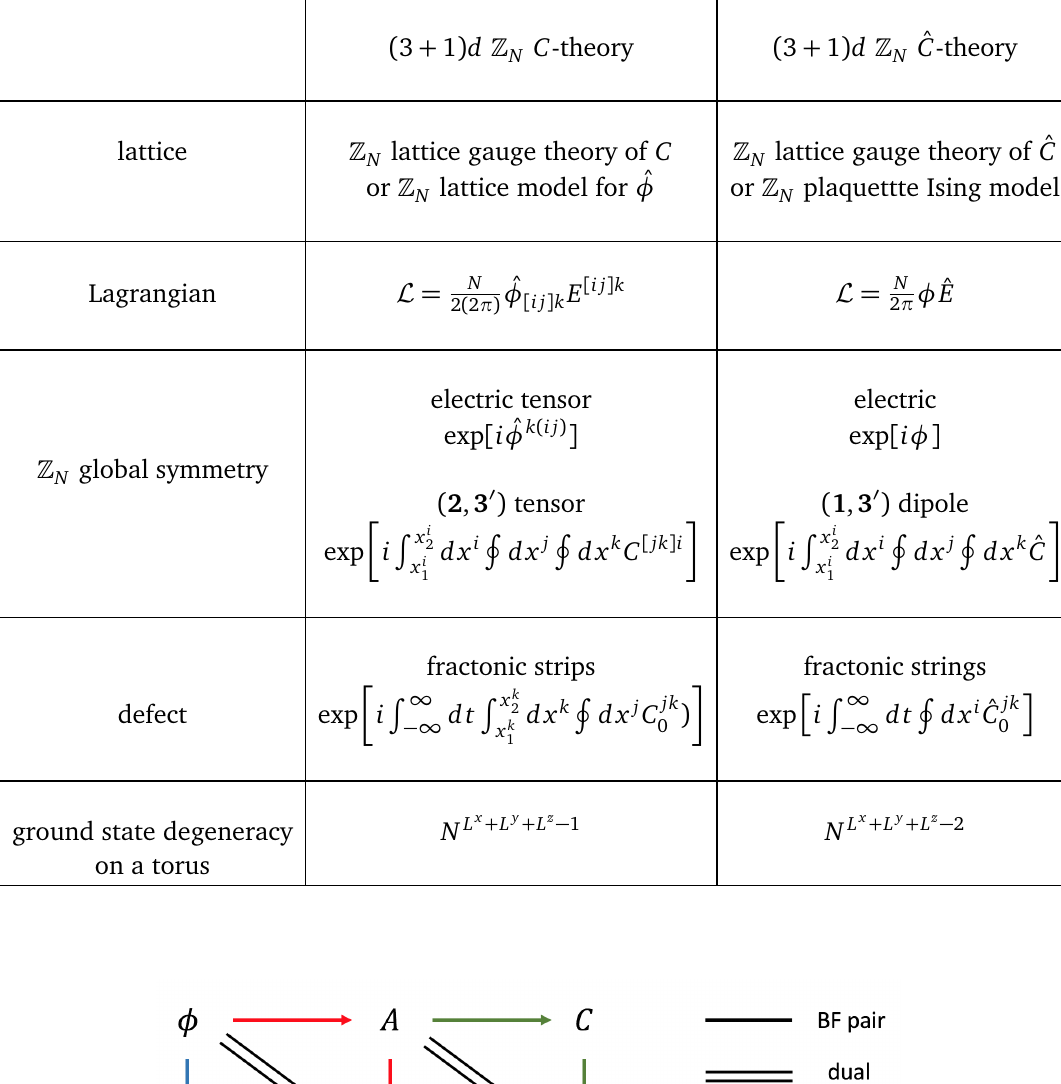
Table 6: The (cid:90) gauge theories of C in Section 6 and of ˆ C in Section 8. The fields N ˆ φ φ are discussed in [ 4 ] . [ ij ] k and